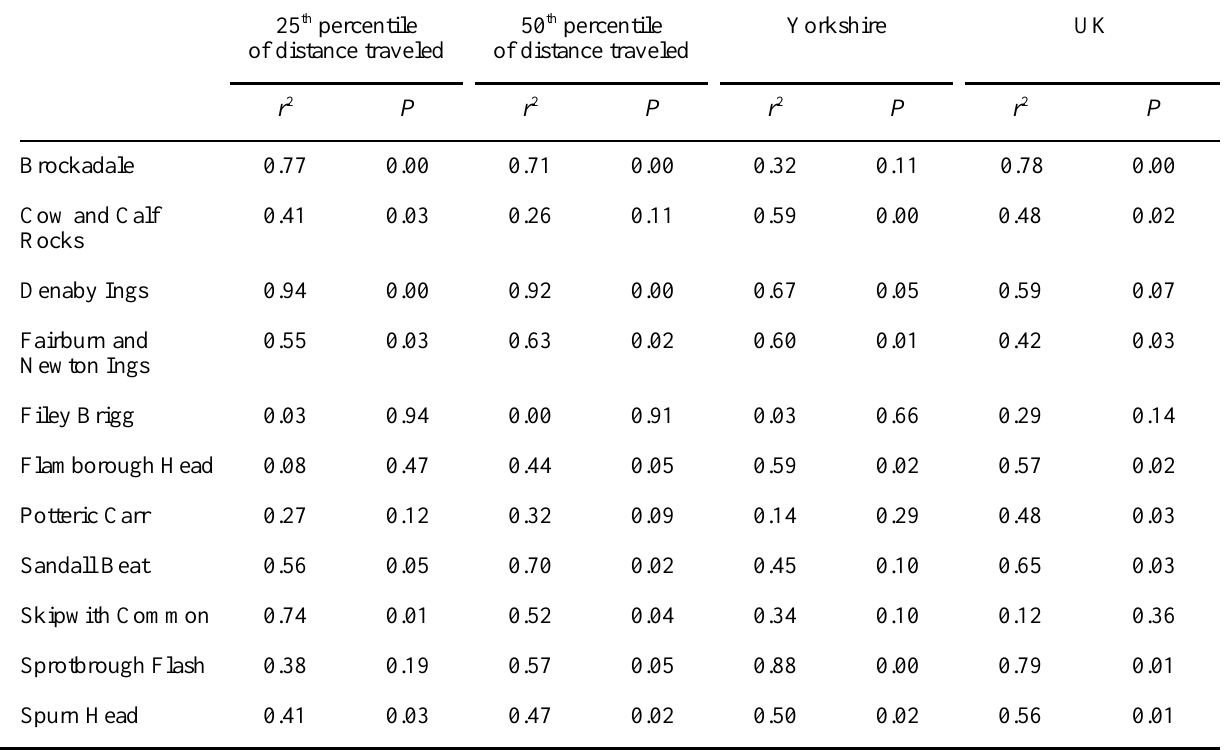
Table 3 . Results of individual site correlations of Mosaic data with reference populations (using Pearson's correlation coefficient and Spearman’s rank correlation as